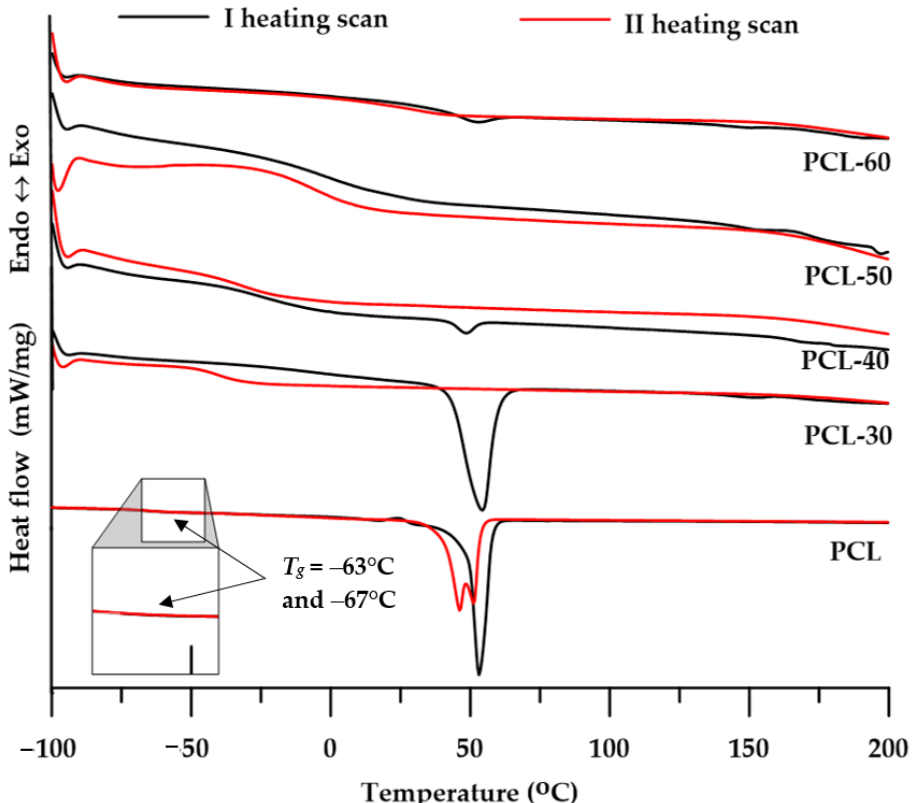
Figure 6. DSC curves of the synthesized polymers.